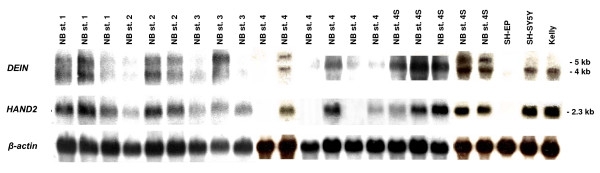
Northern Blot analysis of HAND2 and DEIN expression in primary NB and NB cell lines. Ten μg of total RNA from 20 primary NBs (stage 1, n = 3; stage 2, n = 3; stage 3, n = 3; stage 4S, n = 5; stage 4, n = 6) and NB cell lines SH-EP, SH-SY5Y and Kelly were blotted and hybridized with HAND2- and DEIN-specific cDNA-probes; β-actin was used as loading control.